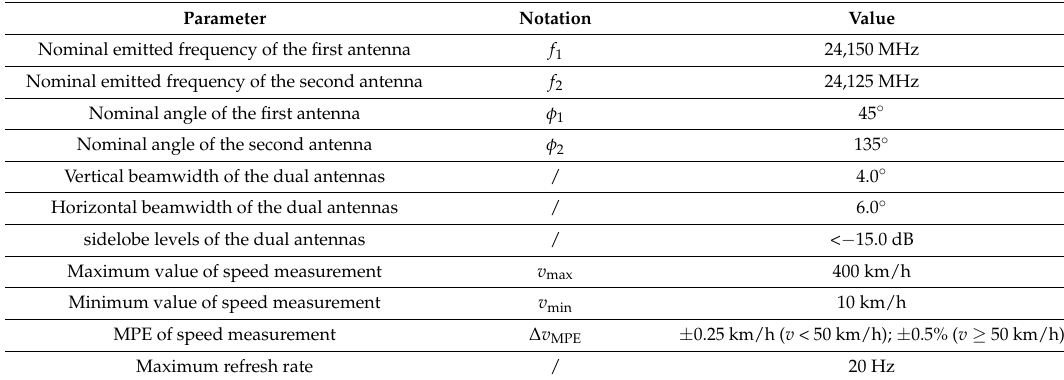
Figure 11. Antenna radiation patterns of the principle prototype: ( a ) vertical plane; ( b ) horizontal plane. Table 2. Main parameters of the principle prototype of the DDRS.